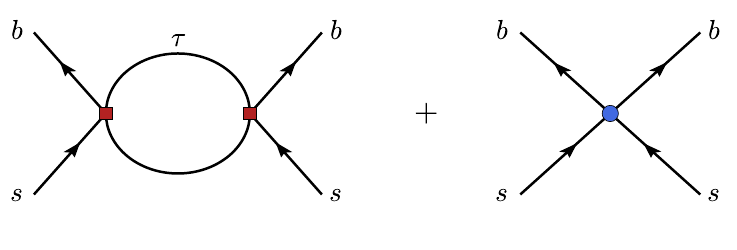
¯ B s mixing in the EFT. The red vertices denote the